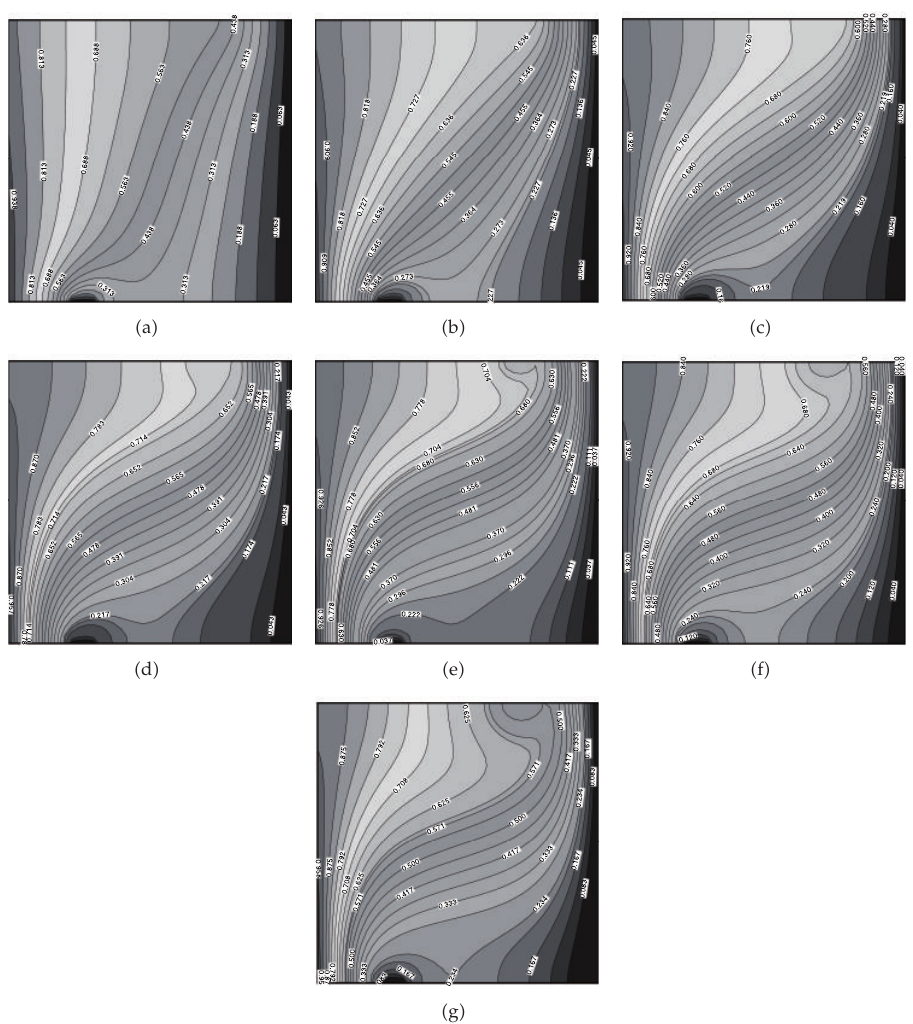
Figure 14: Isoconcentration contours along the left vertical wall while fixing Le (cid:8) 1, D/H (cid:8) 0 . 1, (cid:2) a (cid:3) (cid:8) 0.1, Ra (cid:8) 100, S C (cid:8) 0 . 1 for (cid:2) a (cid:3) B (cid:8) − 1 . 5, (cid:2) b (cid:3) B (cid:8) − 1, (cid:2) c (cid:3) B (cid:8) − 0 . 5, (cid:2) d (cid:3) B (cid:8) 0, (cid:2) e (cid:3) B (cid:8) 0 . 5, (cid:2) f (cid:3) B (cid:8) 1, (cid:2) g (cid:3) B (cid:8) 1 .